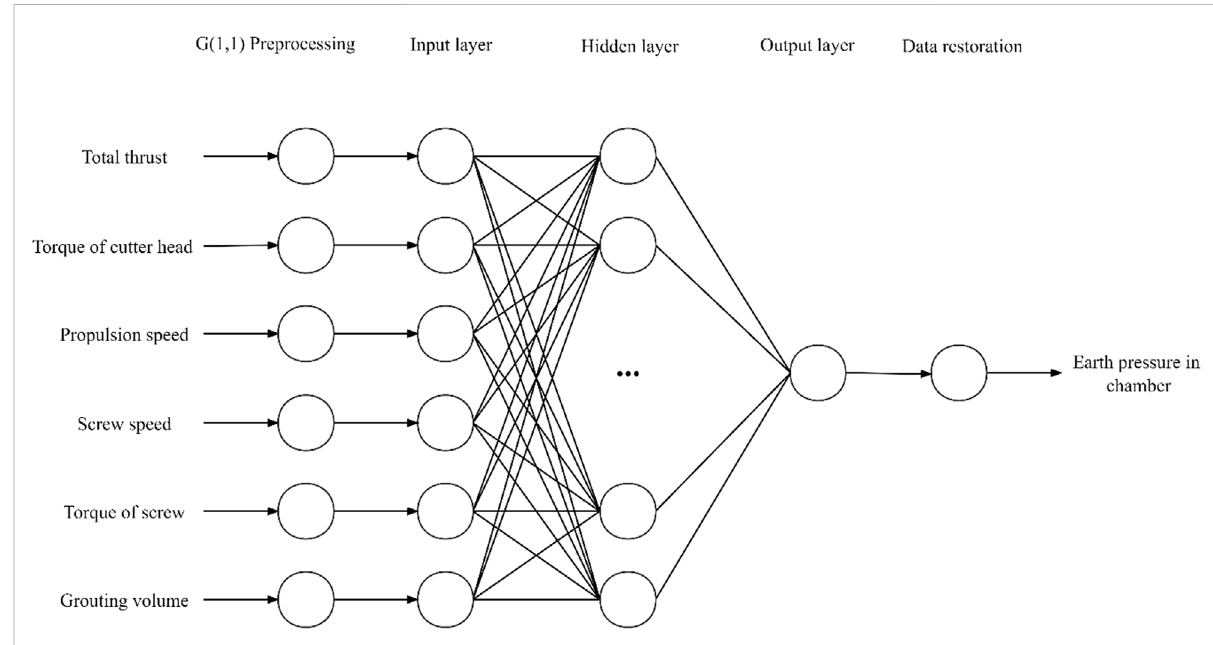
FIGURE 4 Topological structure diagram of prediction model for the Earth pressure in